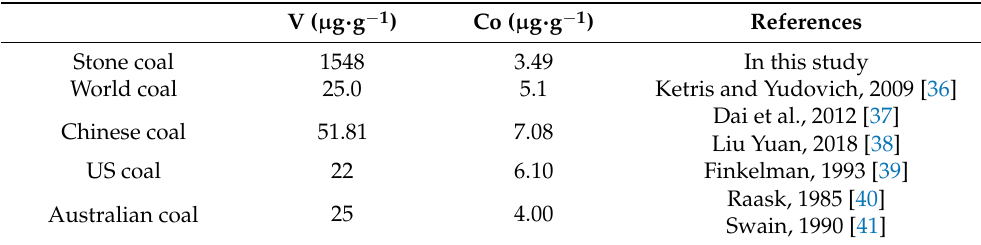
Table 3. Average contents of Co and V in Chinese coal and worldwide